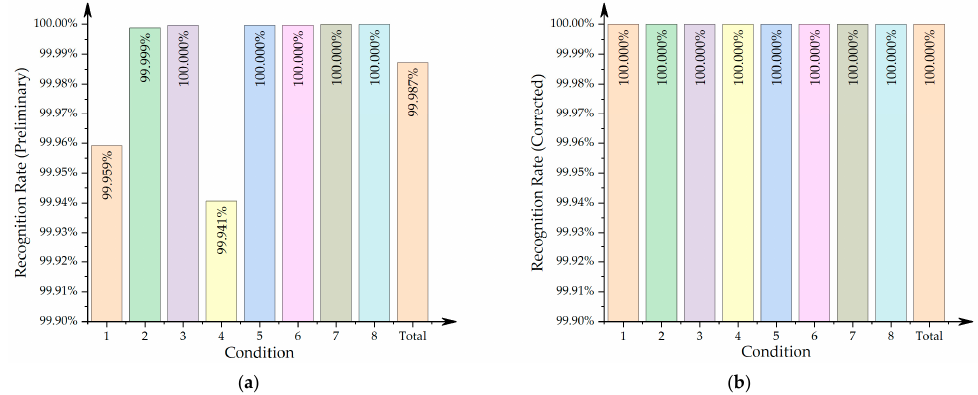
Figure 11. Recognition rate of the teeth slot: ( a ) preliminary result; ( b ) final result (corrected).